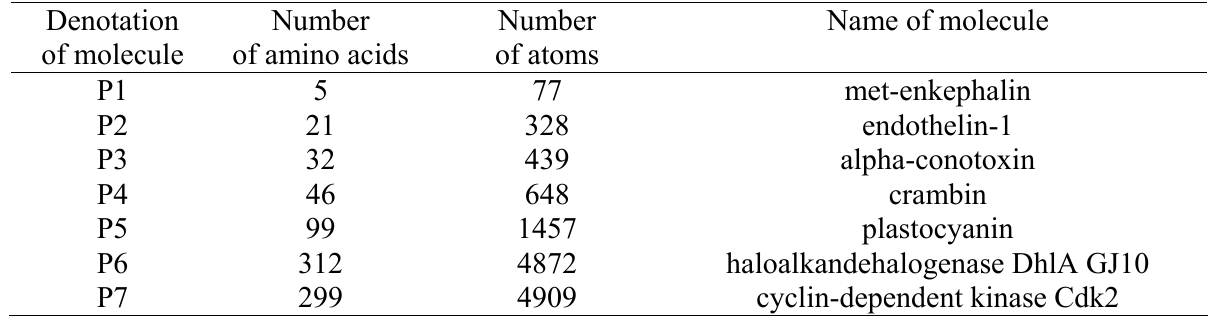
Table 4. Studied peptides and